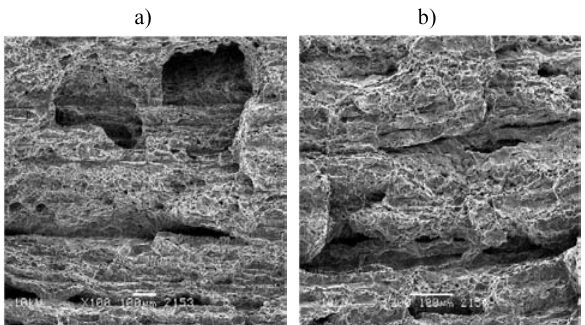
Fig. 7. Fracture morphology of impact resistance samples from tank No. 4 broken at 23 ° C. Plastic fracture. Magni- fication: a) 100 times, b) 200 times